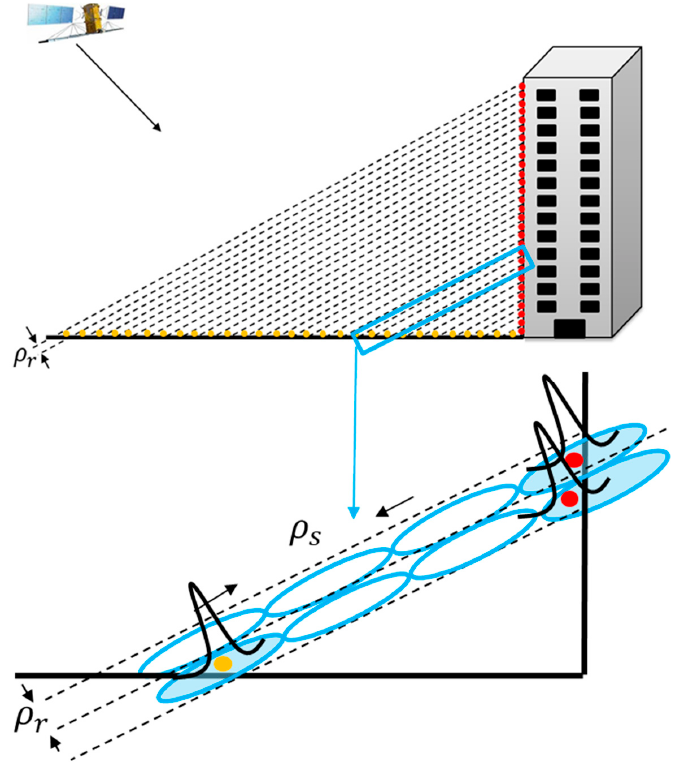
Figure 2. The spatial resolution in the vertical direction depends on the elevation and range resolution.